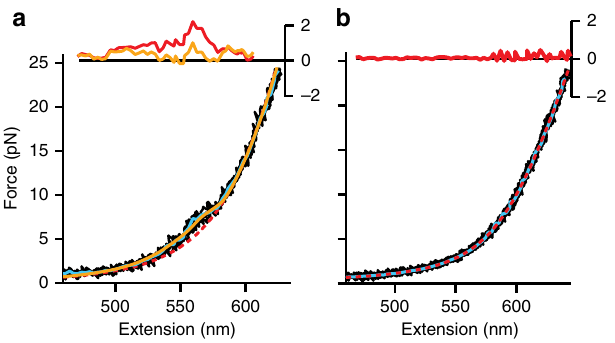
Figure 3 | FECs without discrete transitions. ( a ) From B 4–7pN, these FECs are not well fit by the WLC model (red), leaving a systematic residual (inset). The average of these FECs (cyan) is well fit by a model (equation 2) with two misfolded states fluctuating in equilibrium (yellow). ( b ) FECs of the construct containing DNA handles only (black). Average of FECs (cyan) is fit very well by the expected simple WLC model, as evidenced by the lack of residual (inset), showing no shoulder feature.